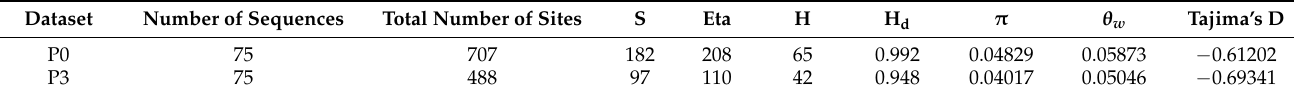
Table 7. Molecular diversity within P0 and P3 sequences of TuYV isolates.